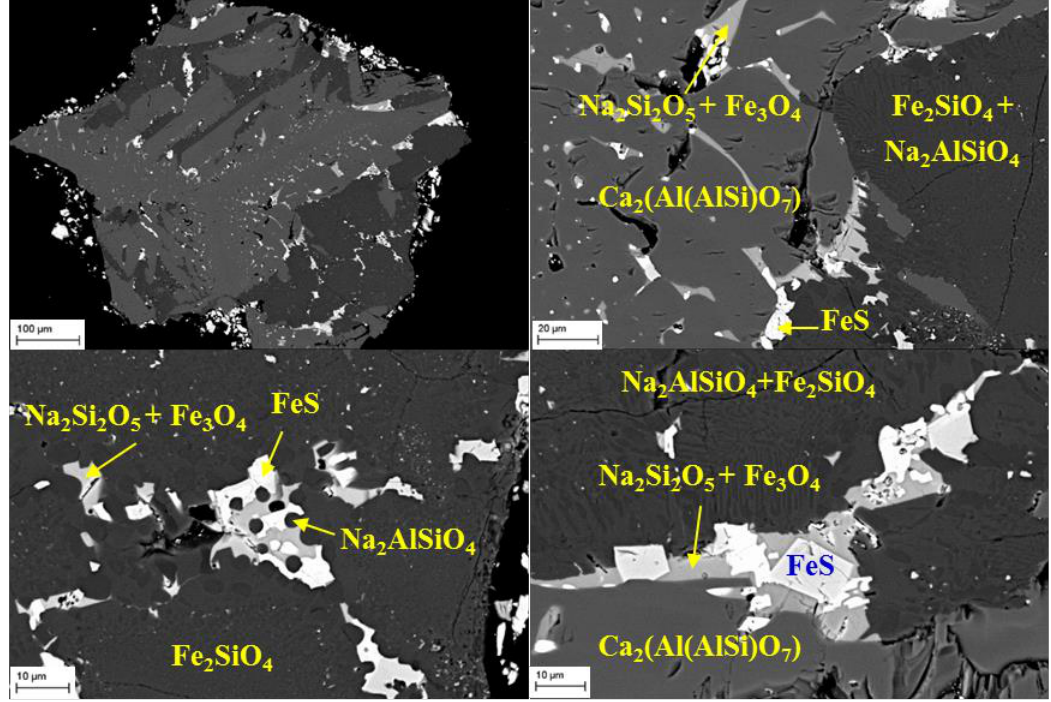
Figure 11. SEM-EDS results of the slag produced from conditions of W lead paste :W Na2CO3 :W pyrite cinder :W coke = 1500:60:375:180 g, FeO/SiO 2 = 1.3, CaO/SiO 2 = 0.4, 1200 °C, and 1.5